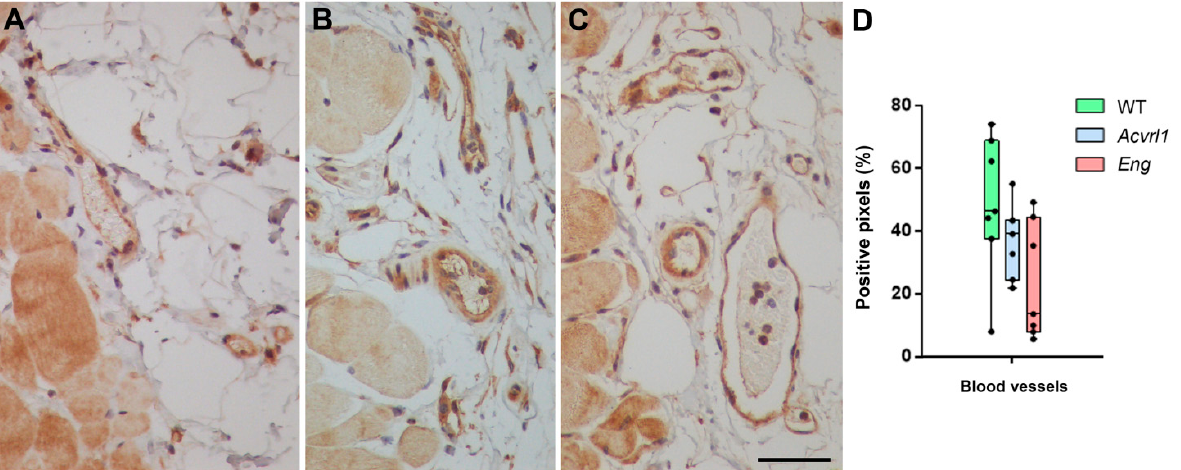
Figure 9. Representative photographs of small blood vessels in the dorsal skin of WT animals ( A ) and mutants for Acvrl1 ( B ) and Eng ( C ), stained with the anti ‐ AM antibody. The endothelium and the smooth muscle cells appear clearly stained. ( D ) Quantification of the immunohistochemical signal. Box plots represent the interquartile range with the median as a horizontal line. Whiskers encompass the maximum and minimum values of the population. Dots represent individual animals. Scale bar for ( A – C ) = 50 μ m.